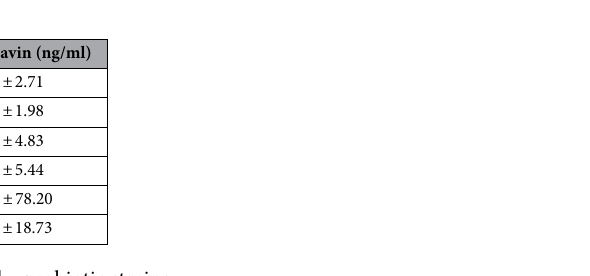
Table 1. Amount of riboflavin produced by probiotic